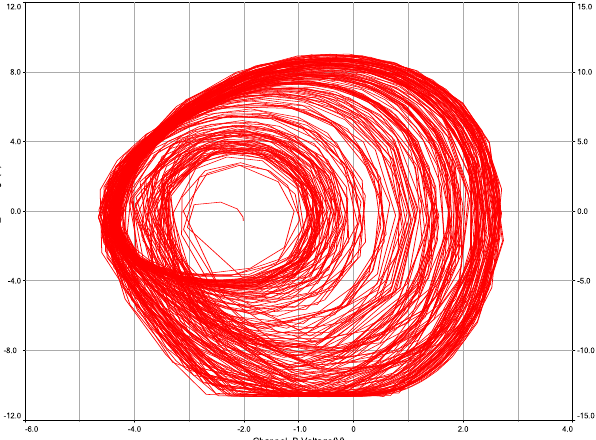
Figure 10. NI Multisim’s digital oscilloscope output for the proposed circuit with R 6 = 1807 Ω .